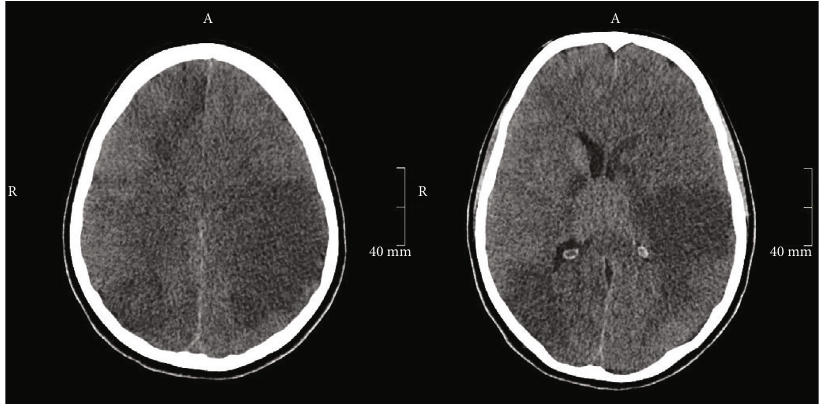
Figure 2: Computed tomography of the brain evidencing a large hypodense area with e ff acement of the cortical sulci and midline shift, suggesting a malignant ischemic